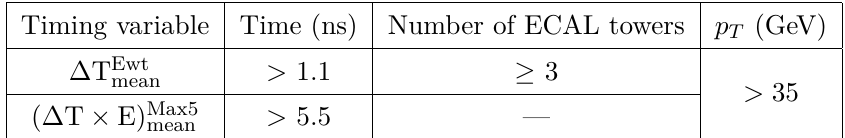
Table 2 . Selection cuts for the two dedicated timing triggers with thresholds for the two jet timing variables, number of ECAL towers associated with a jet and the jet p rate ≈ 30